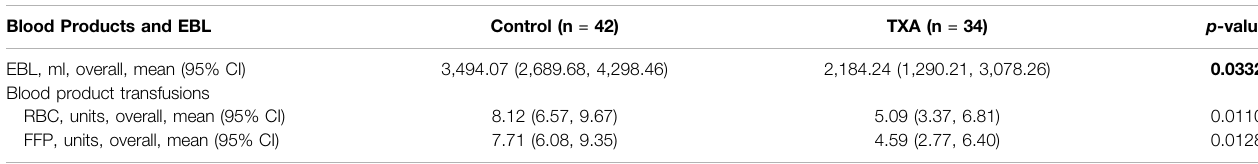
TABLE 2 | Estimated blood loss and amount of intraoperative blood transfusion from univariate models. Blood Products and